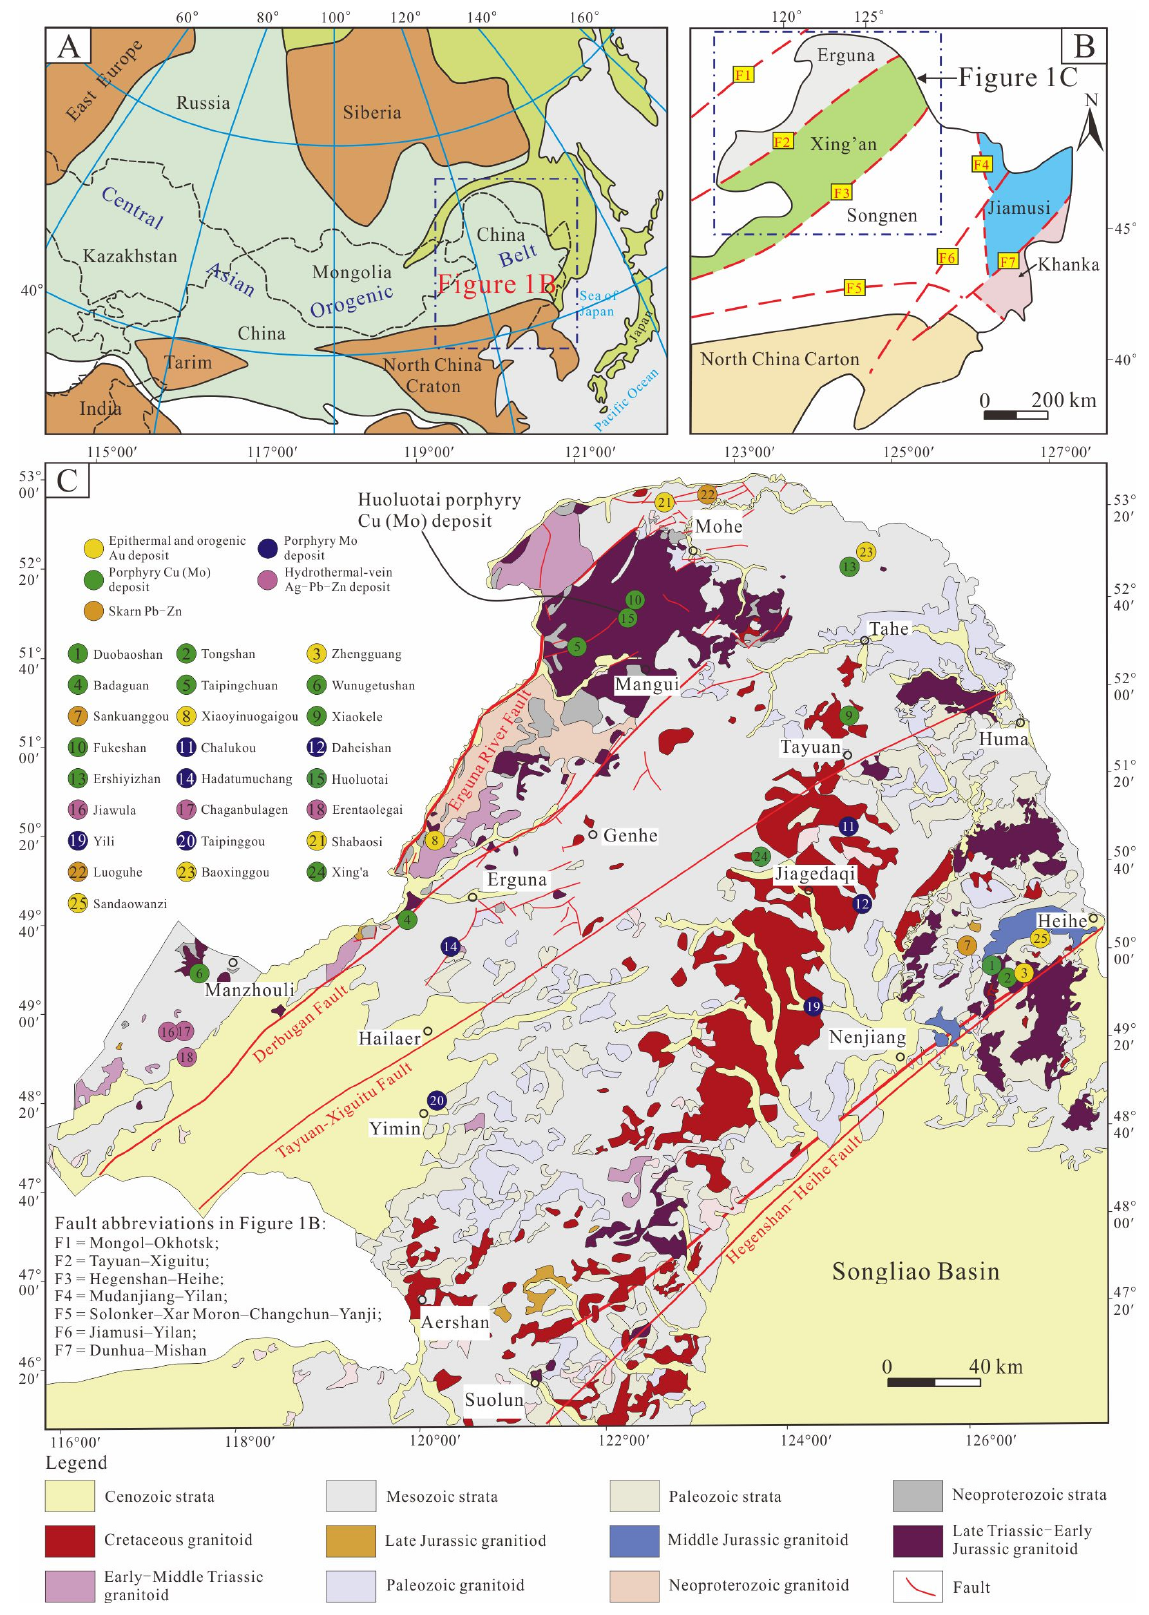
Figure 1. ( A ) Location of the CAOB [6]. ( B ) Geological map of NE China [7]. ( C ) Geological map of the NGXR (modified from